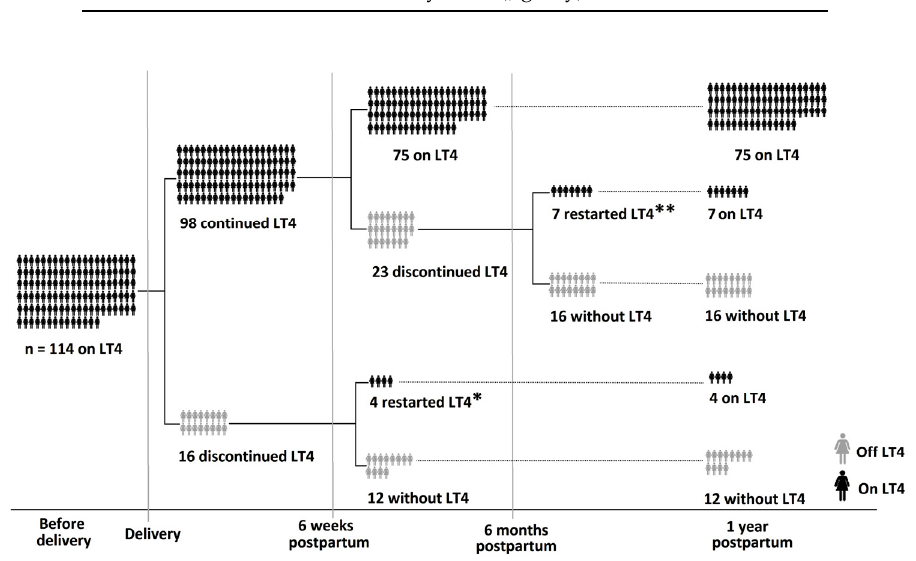
Figure 1. Flowchart of the 1-year postpartum follow-up. One year after delivery, most patients (86/114 (75.4%)) were still on levothyroxine treatment (LT4). In total, 11 out of 39 women who